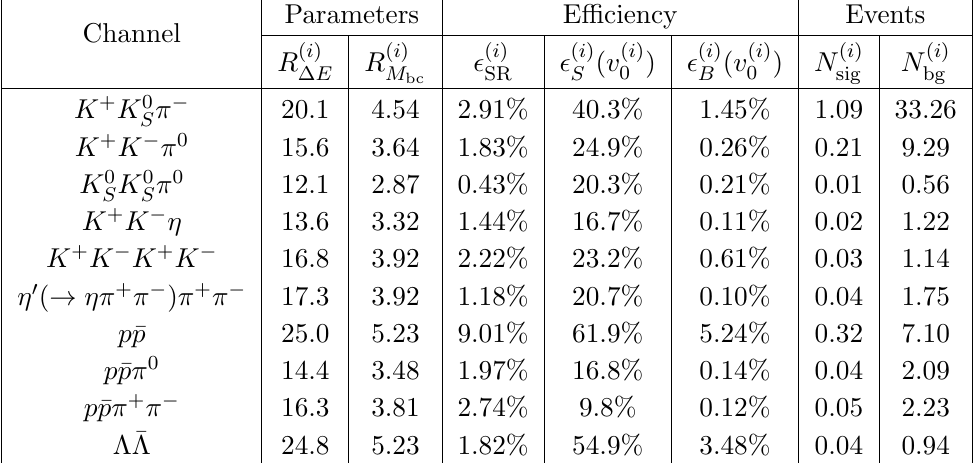
Results of the optimization of the selection requirements for the channel The expected number of signal events is calculated assuming B 0 ! ( B 0 ( (cid:17) (1 D ) 10 (cid:0) 5 . The e(cid:14)ciencies and expected numbers (cid:17) c 2 (1 D ) (cid:25) (cid:0) K + ) h c (cid:13) ) = 1 : 0 c 2 B ! (cid:2) B ! (cid:2)